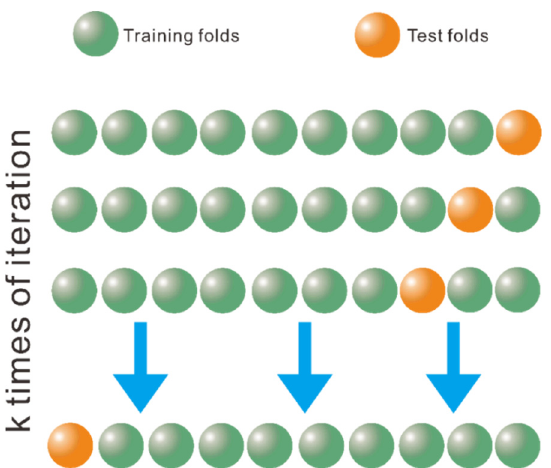
Figure 2. The scheme of the k-fold cross-validation, which divides the dataset into training folds and test folds for k times of learning iterations.